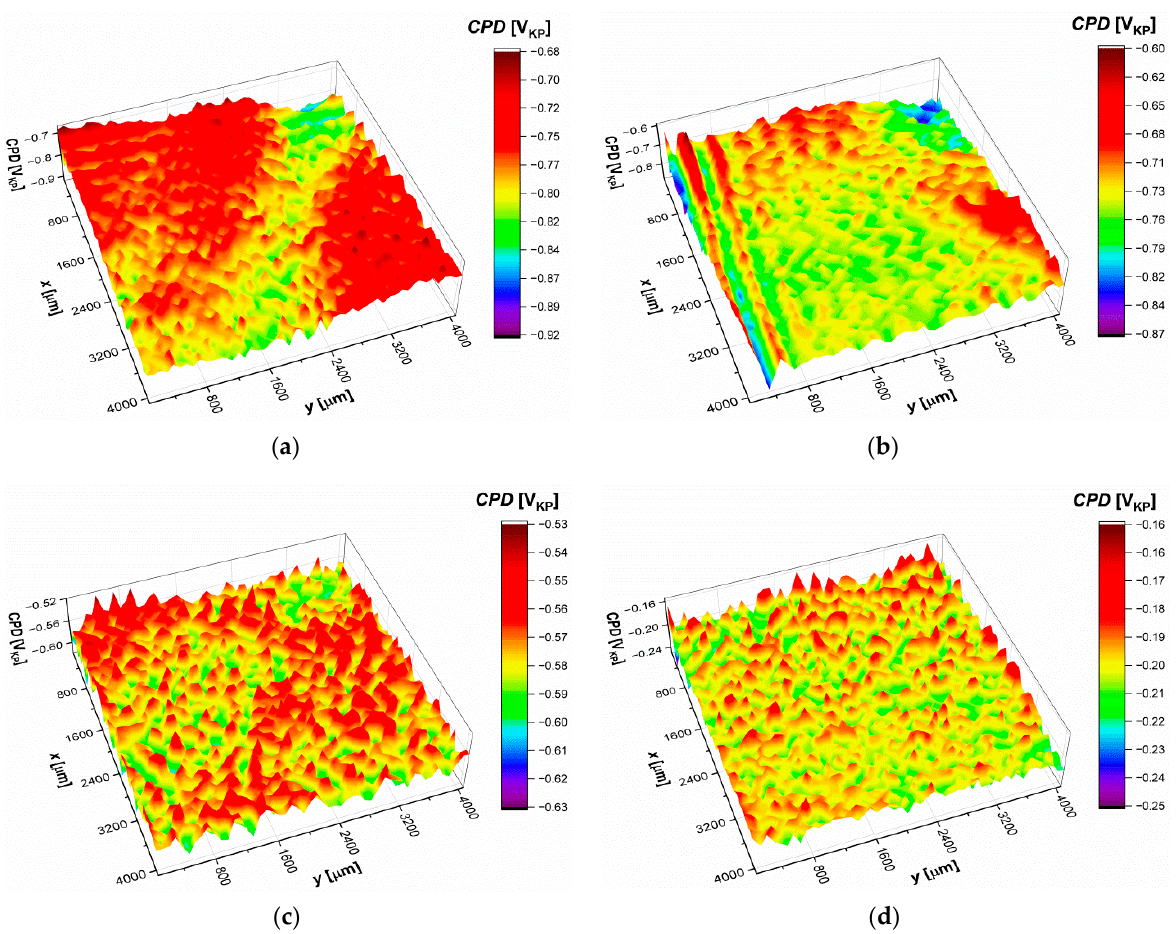
Figure 10. The contact potential difference maps determined for the Ti ‐ 6Al ‐ 7Nb alloy surface: ( a ) before oxidation; ( b ) after oxidation at 600 °C; ( c ) after oxidation at 700 °C; ( d ) after oxidation at 800 °C. V KP is the voltage measured versus the Kelvin probe.